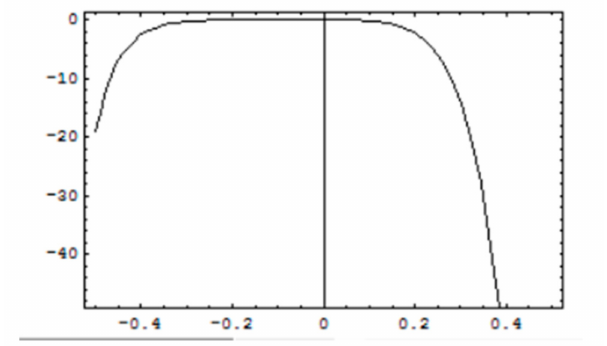
Figure 6. h -curves for the solution of θ ( 0 )